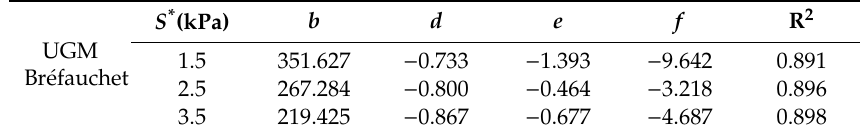
Table 4. Parameters of the model based on suction.